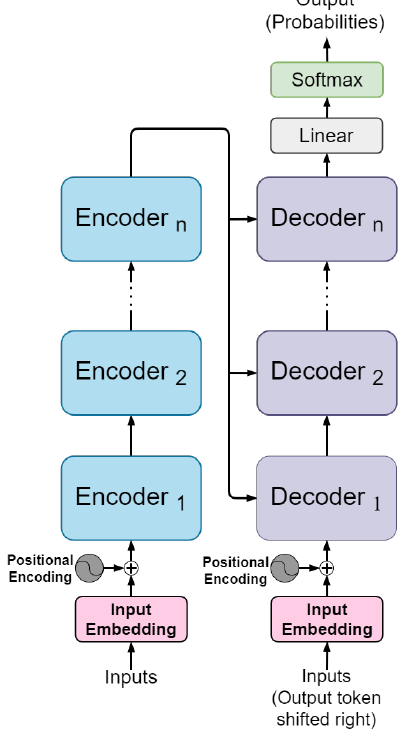
Figure 4. An illustration of transformer